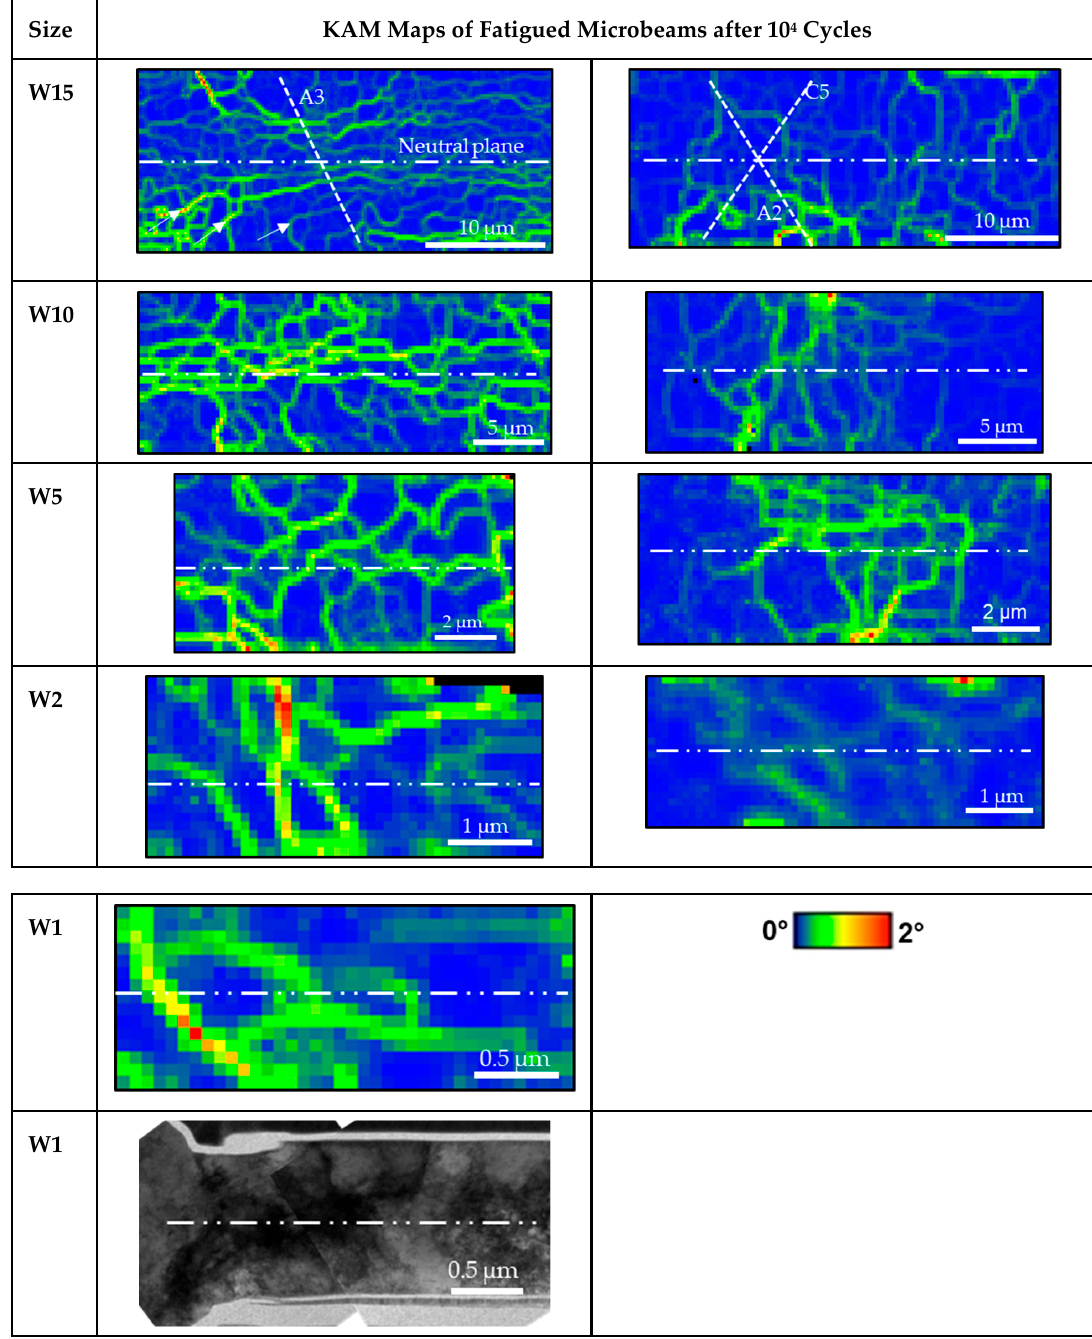
Figure 6. Kernel average misorientation (KAM) maps showing the evolution of the dislocation structures of the microbeams with the orientation A (left column) and orientation B (right column): The KAM maps on the left side are of the beams in Figure 4 deformed with Δε p ≈ 0.2% and the KAM maps on the right side of the microbeams with orientation B in Figure 5 (these KAM images were taken on the top surface of the beams (surface 1 in Figure 1b)). The TEM image of a beam with the width of 1 µm on the left side showing diffuse structures was used for a qualitative comparison with the KAM image of beam size W1.